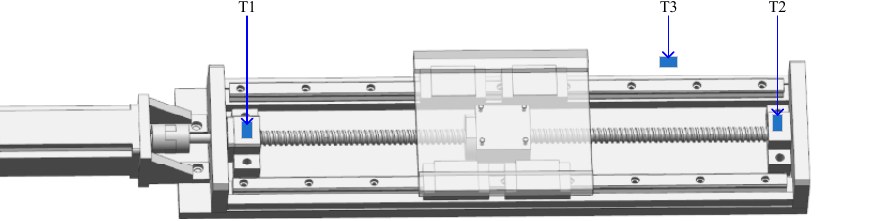
Figure 1. Experimental equipment and experimental schematic diagram: ( a ) Experimental equip- ment; and ( b ) experimental schematic diagram. Figure 2. The layout of the temperature sensors.